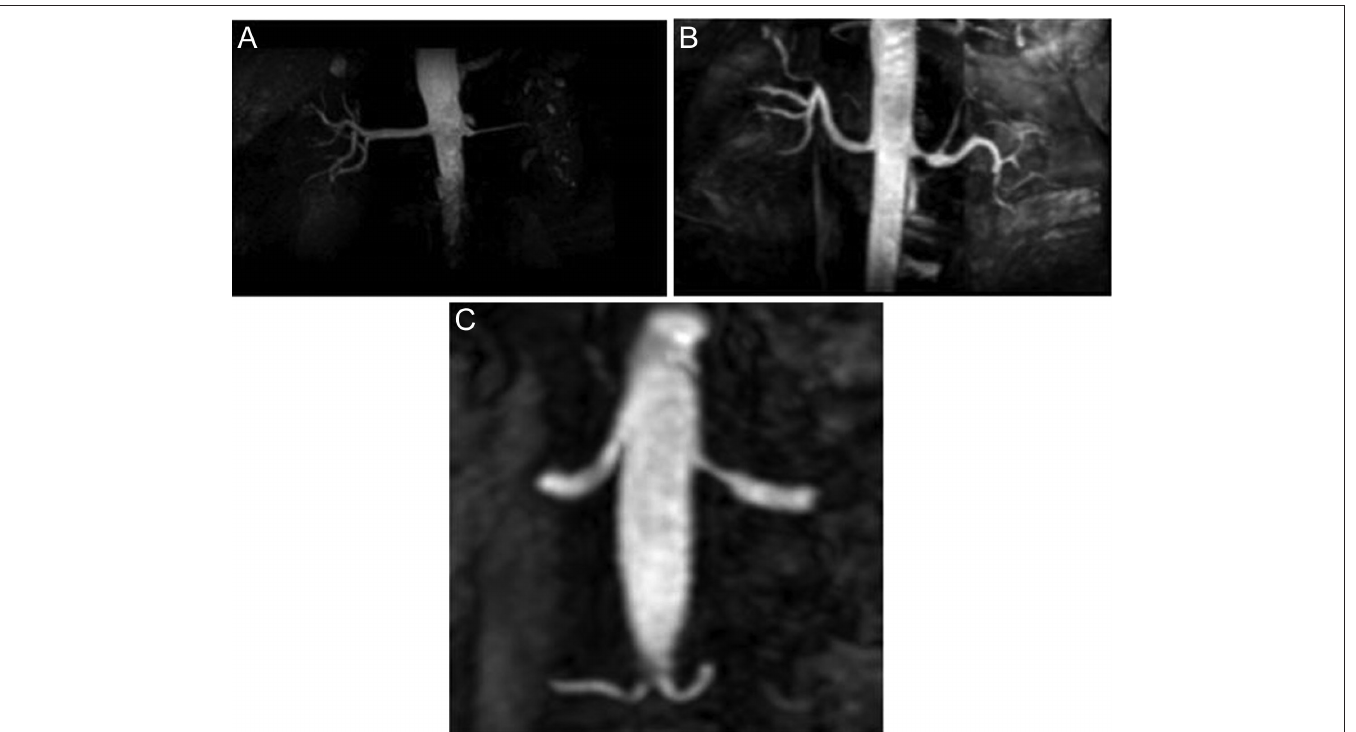
Figure 3. Coronal reformatted MIP images of Inhance sequence for (A) a 58-year-old male patient, left renal artery (long segment) chronic stenosis (arrow), ischemic nephropathy, and atrophic left kidney, (B) a 60-year-old female patient, left renal artery proximal stenosis (arrow), post-stenotic dilatation (curved